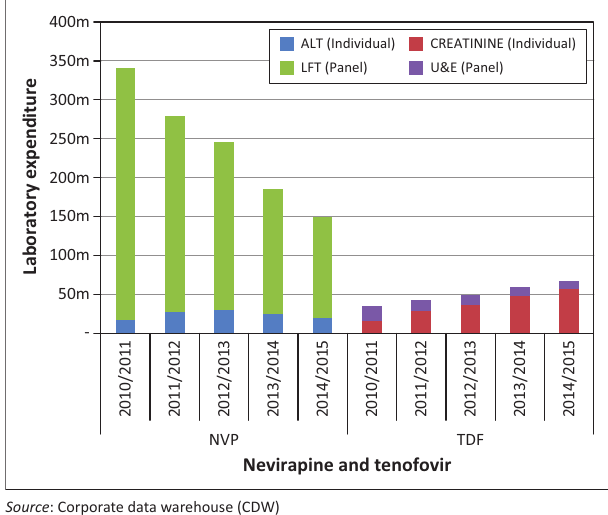
FIGURE 1: Annual laboratory expenditure for nevirapine and tenofovir toxicity monitoring of antiretroviral treatment patients 2010/2011 to 2014/2015 by panel (liver function test and urea and electrolytes) and individual testing (antiretroviral treatment and creatinine), ZAR millions.